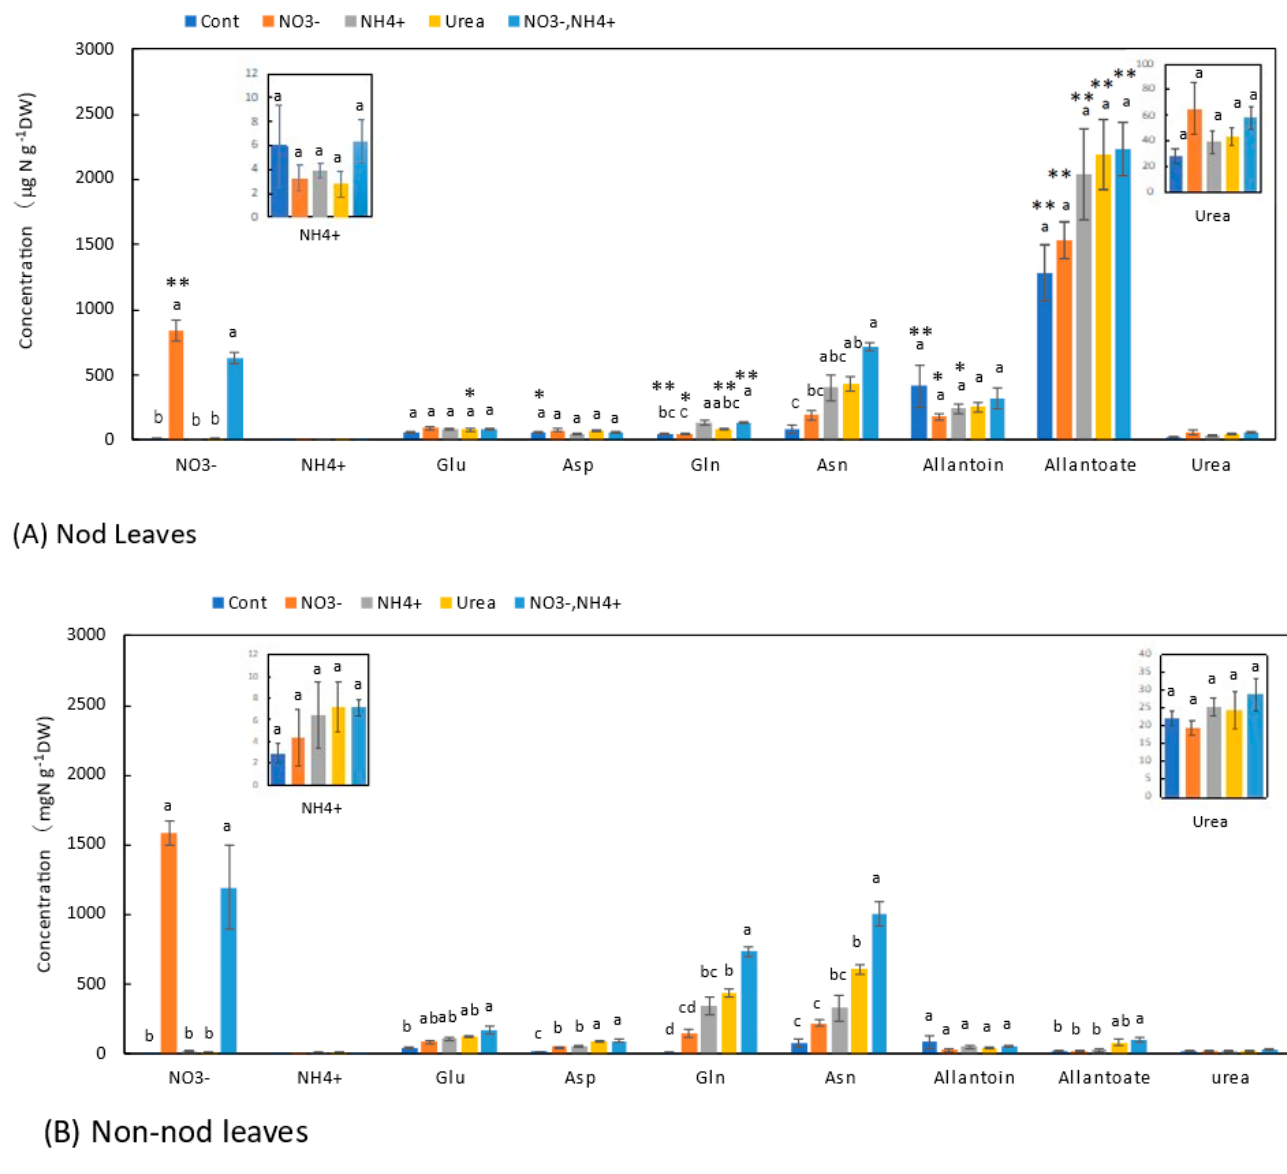
Figure 7. Comparison of the concentrations of the principal N metabolites in the leaves of the Nod and Non-nod soybean plants treated with various N compounds. The symbols, abbreviations and the explanations of the statistics are the same as in Figure 2.